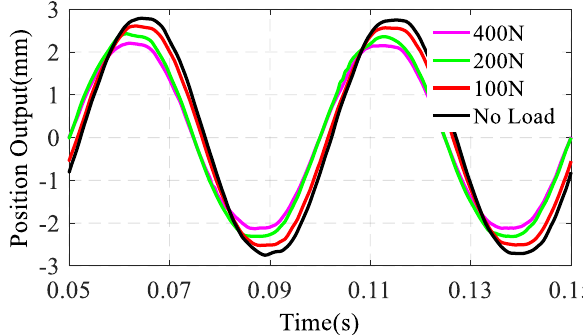
Table 2. Amplitude attenuation with spring force load.